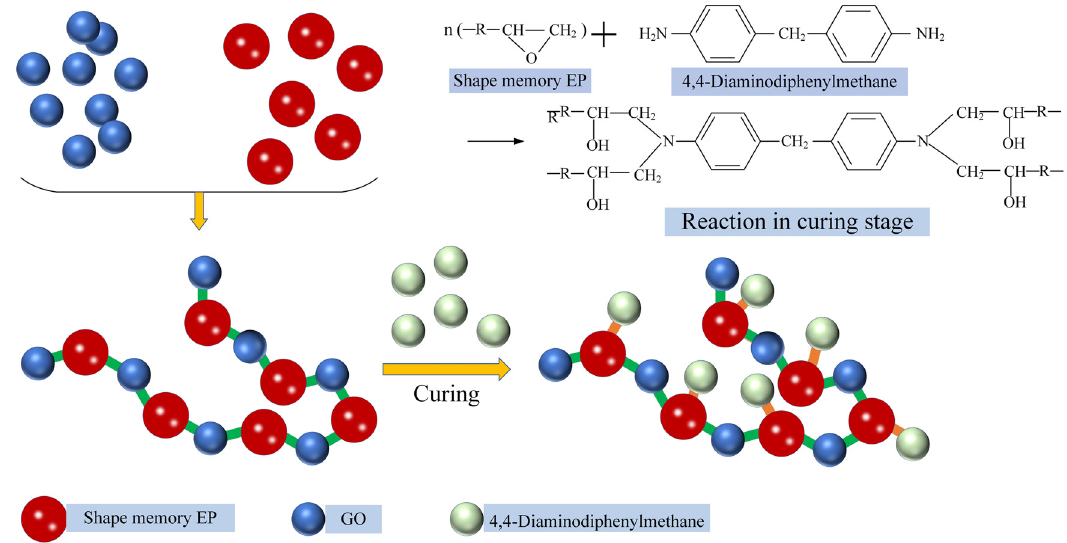
Figure 1: Schematic of reaction mechanism during preparation of SMGO/EP